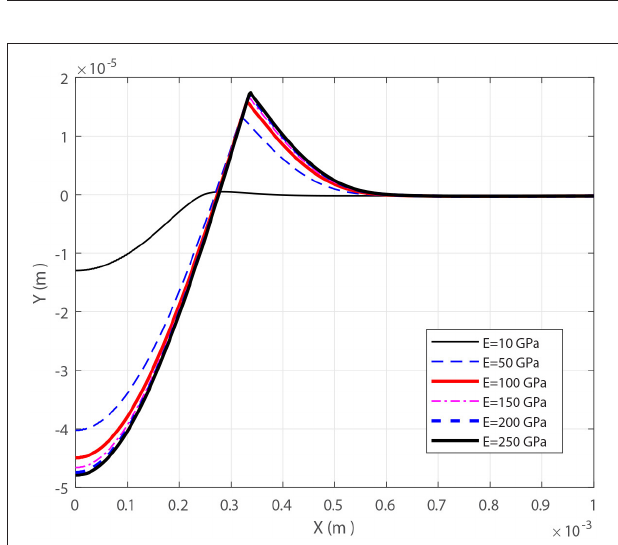
FIGURE 8 | Effect of the indenter modulus of elasticity on surface profile for a elastic-perfectly plastic material.